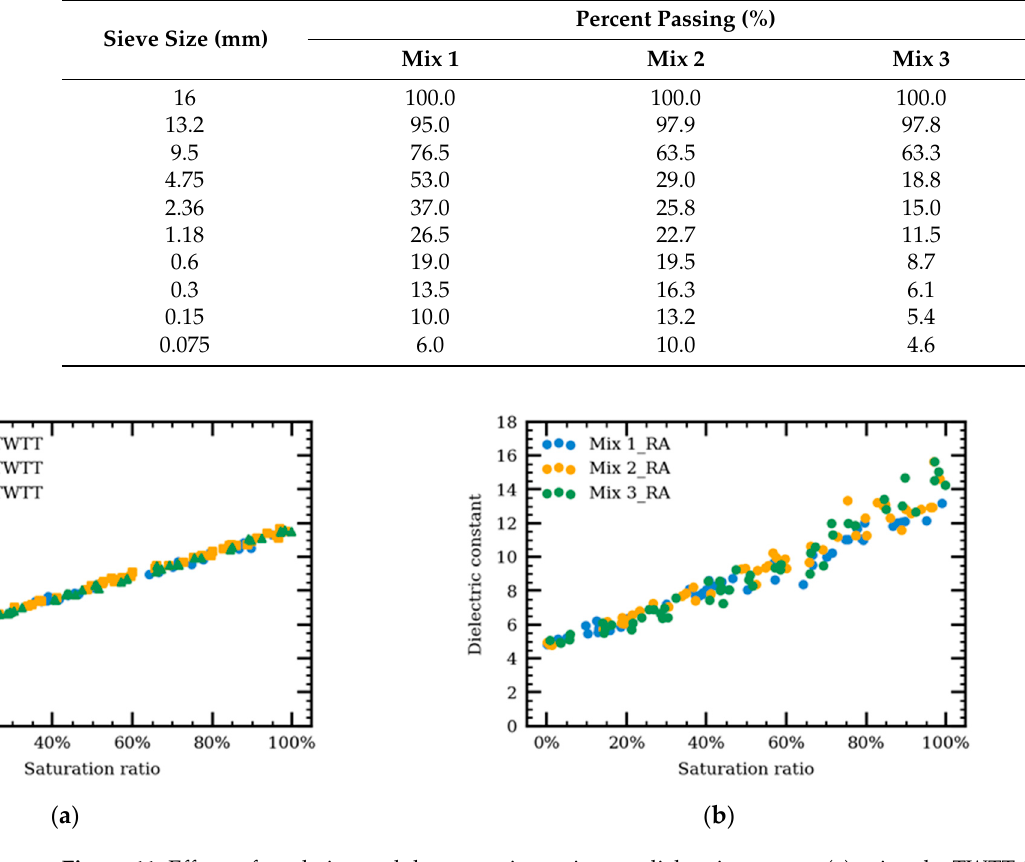
Figure 11. Effects of gradation and the saturation ratio on a dielectric constant using the TWTT ( a ) and RA ( b ) methods.